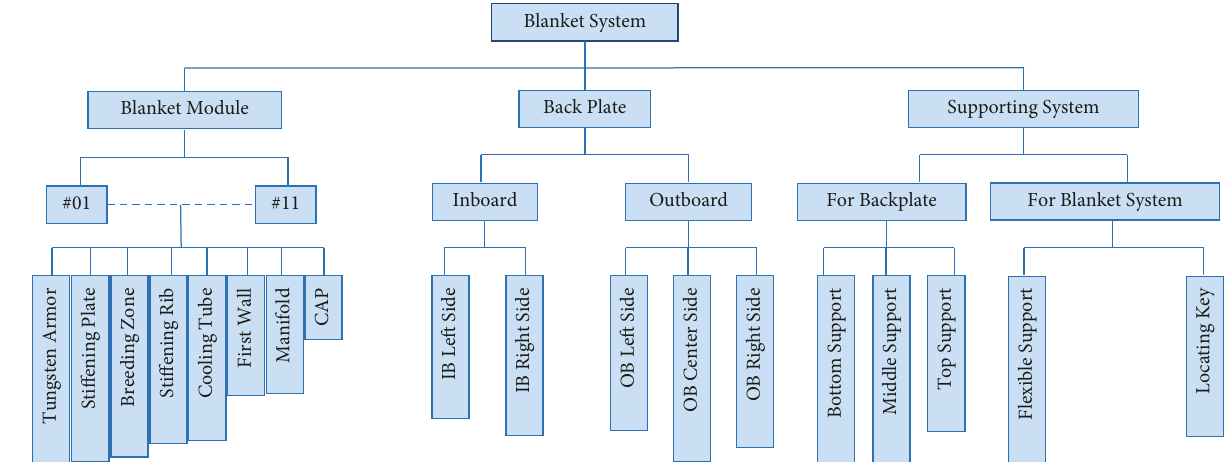
Figure 5: The overview of the blanket system hierarchy structure.